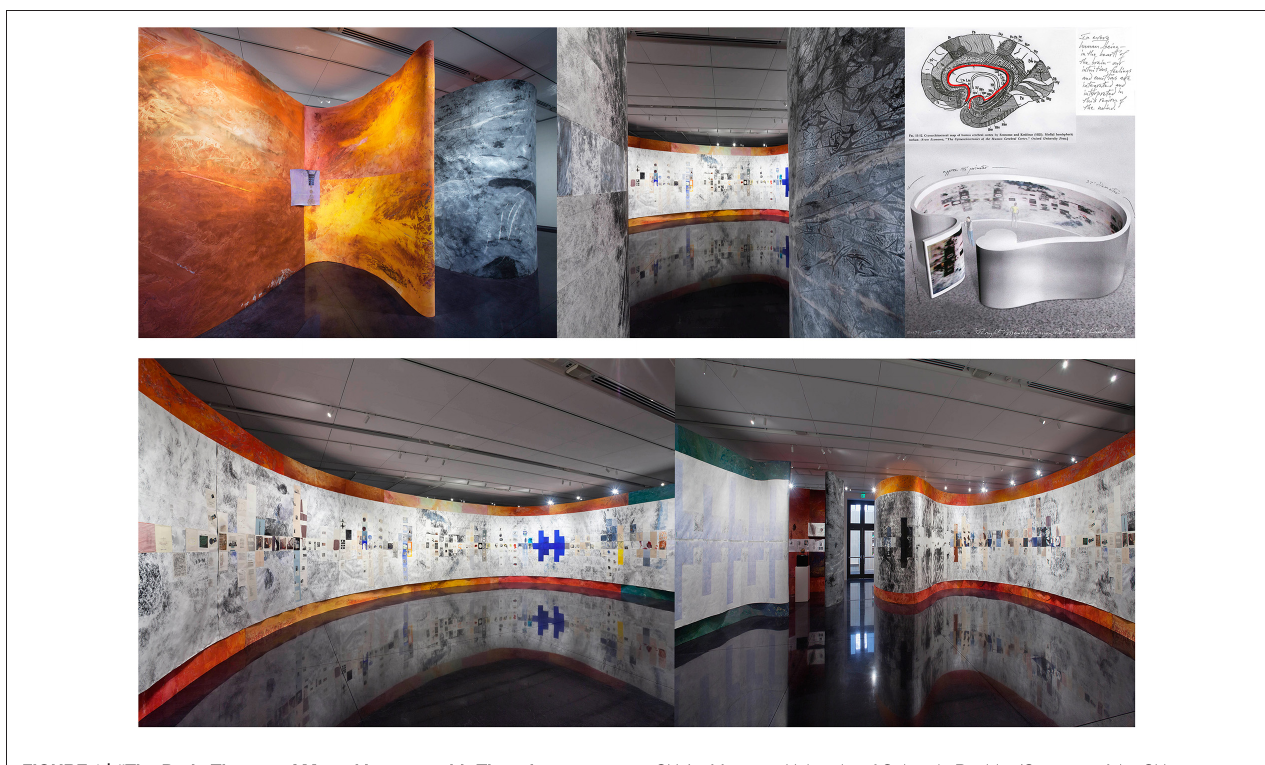
FIGURE 1 | “The Brain Theater of Mental Imagery with Thought Assemblies emerging from the Limbic System,” (1979–82, 2014). Mixed media on synthetic canvas with collage elements, 11 ft. × approx. 145 ft. perimeter × 37 ft. diameter. Installation view: